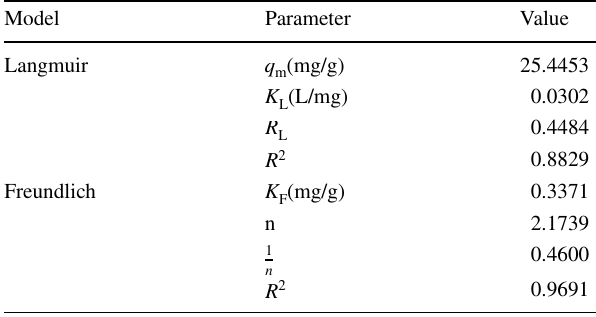
Table 1 Langmuir and Freundlich model constants for Cd(II) sorp- tion by UMSFS